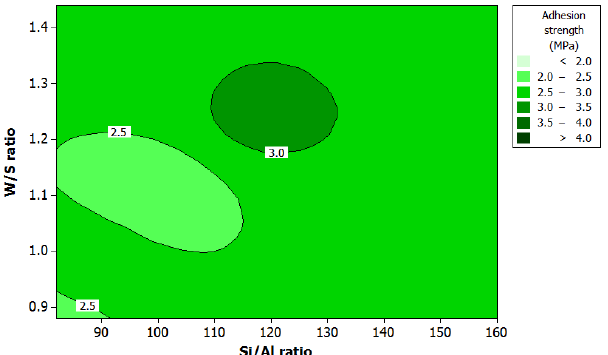
Figure 7. Contour plot of adhesion strength, W/S ratio, and Si/Al ratio.